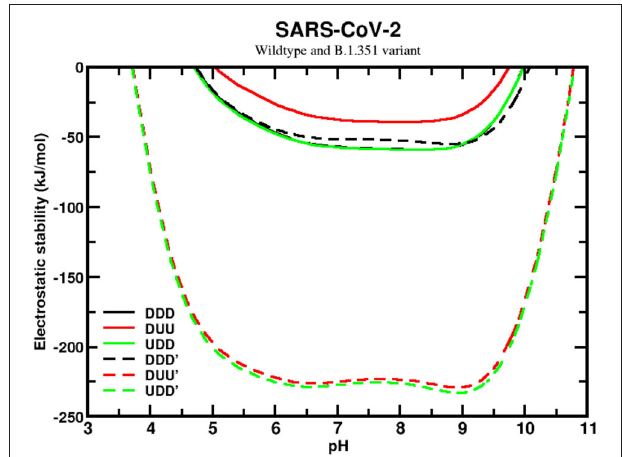
FIGURE 6 | Simulated electrostatic stability profiles for the sequences of the SARS-CoV-2 wt and the South African (B.1.351) spike homotrimers as a function of pH. The chains are in three different conformational states: DDD, DUU, and UDD, which are represented in black, red, and green, respectively. The continuous lines refer to SARS-CoV-2 wt, and the dashed lines refer to the South African variant (B.1.351). All other details are given in Figure 5